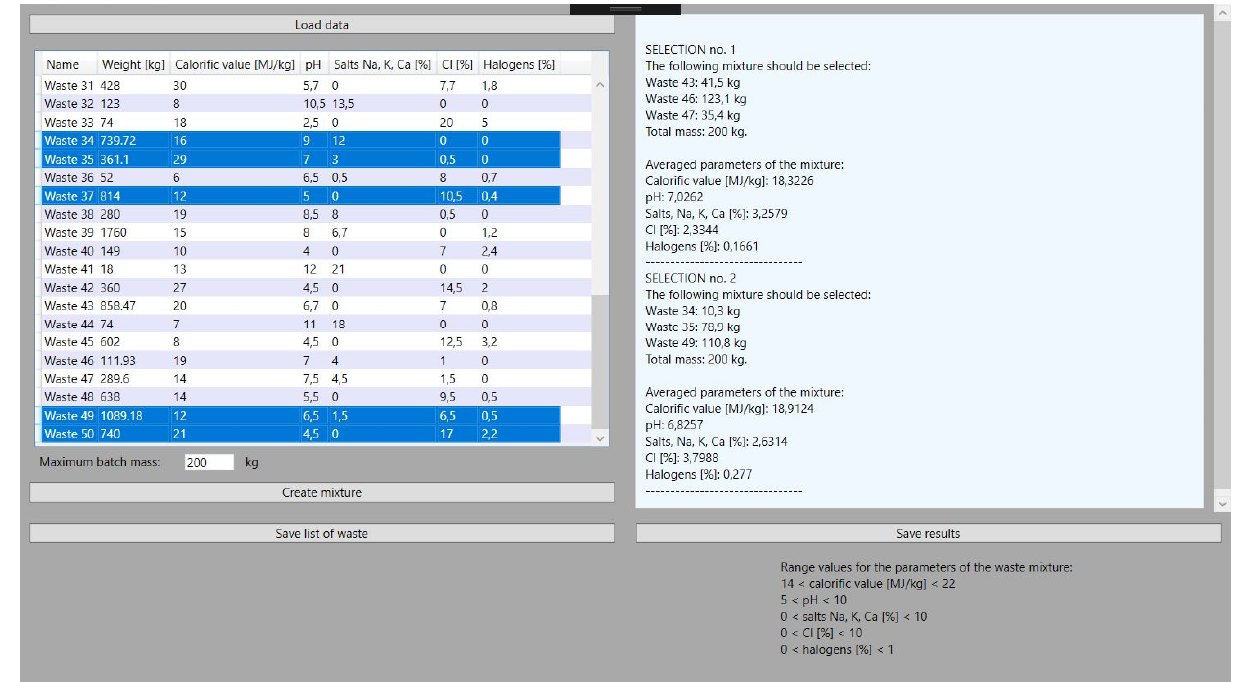
Figure 8. Results obtained for the second mixture.